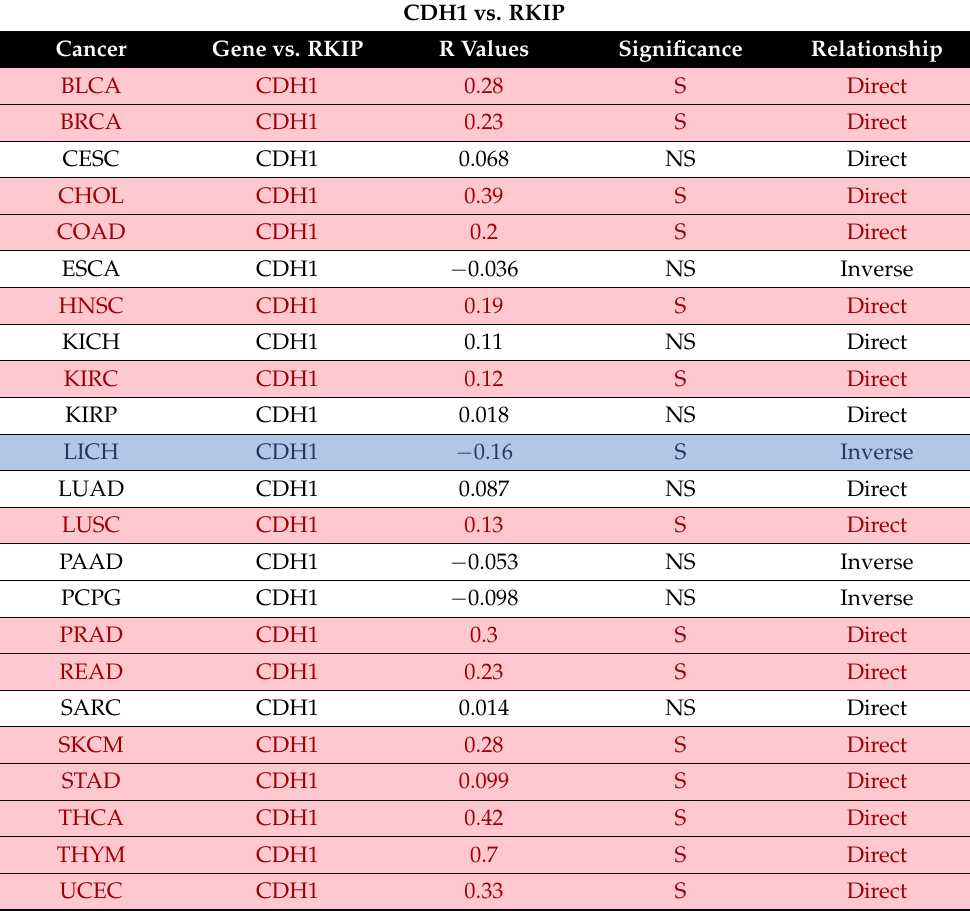
Blue: Significant Inverse Relationship; Red: Significant Direct